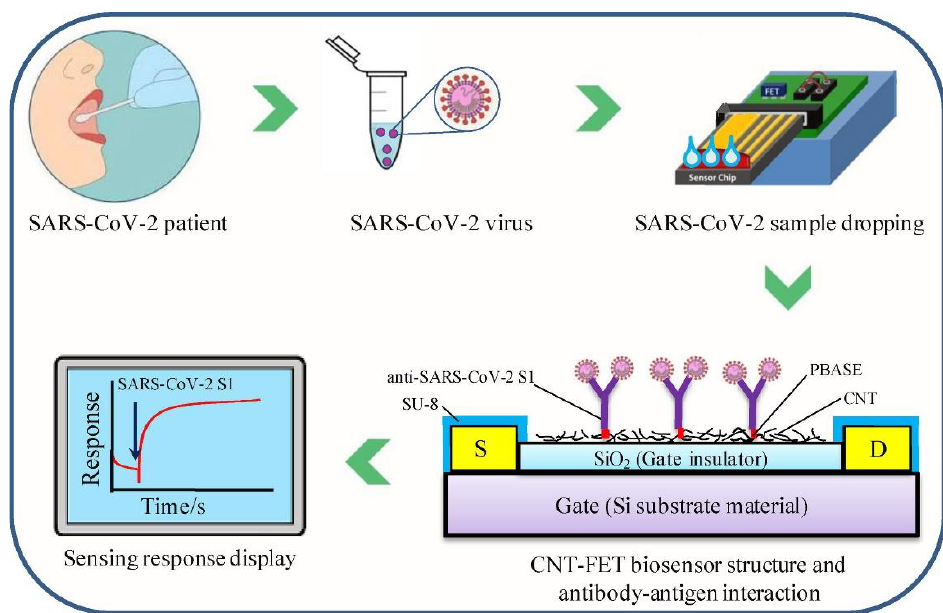
Figure 4. Schematic illustration of the COVID-19 testing steps via CNT-FET biosensor. 1 µ L SARS- CoV-2 S1 antigen mixed with 99 µ L healthy human saliva to mimic SARS-CoV-2-positive saliva was used as a test sample. The sample was dropped onto the SWCNT surface where anti-SARS-CoV-2 S1 was immobilized via the PBASE linker. SARS-CoV-2 S1 antigen detection was based on the change in S-D current (IDs). The change in the electrical signal characterized the antigen binding effect. Reprinted with permission from [102].